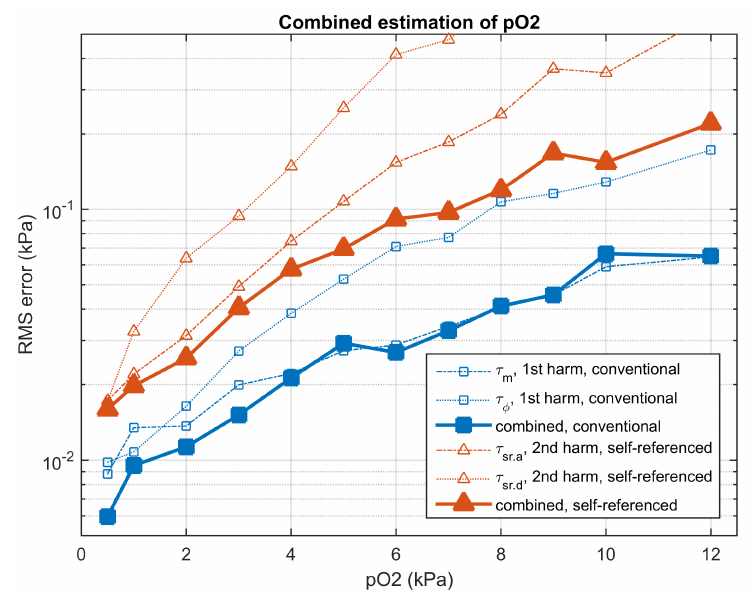
Figure 10. Root mean square (RMS) error (in kPa) in the oxygen determination for the conventional (blue squares) and self-referenced (red triangles) methods. The thin lines represent estimations using an individual apparent lifetime ( τ m or τ φ for the first harmonic in the conventional method, τ sr . a and τ sr . d for the second harmonic in the self-referenced method). The solid lines represent the oxygen determinations combining both apparent lifetimes for all the available harmonics. Experimental results obtained from the evaluation